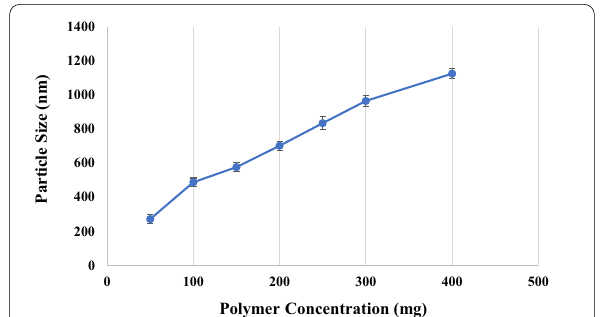
Fig. 1 Influence of chitosan concentration on the particle size